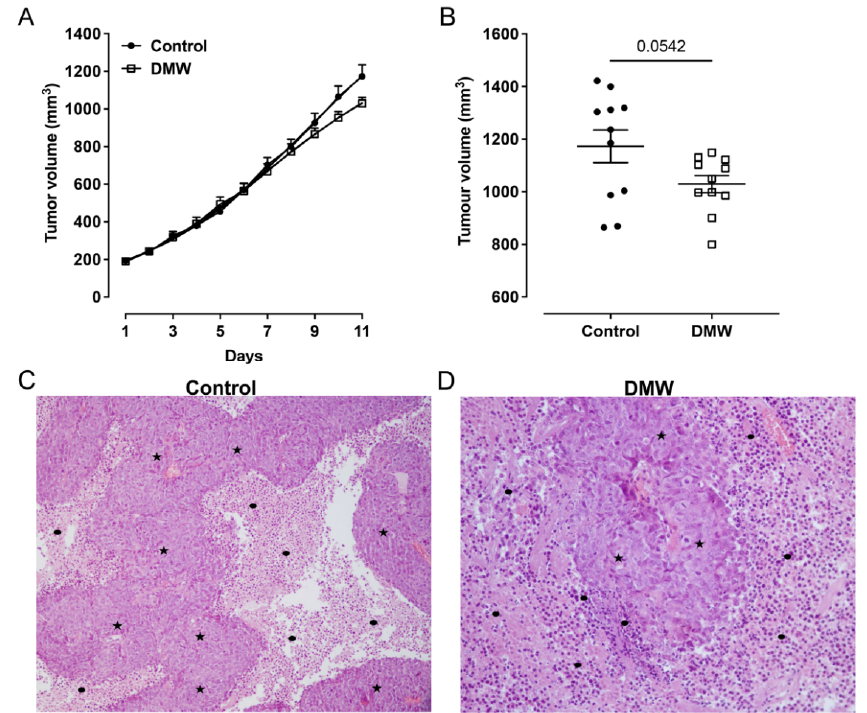
Figure 1. DMW does not significantly reduce CRC growth in vivo. ( A , B ) Effect of DMW (0.2 mL/mouse, given by oral gavage) on in vivo tumour growth, measured as tumour volume (mm 3 ), over an 11-day period. Each point is the mean ± SEM of 11 mice. ( C , D ) Histological features of control- and DMW-treated samples. Representative images of ( C ) control sample showed adenocarcinoma (stars) with central necrosis (dots) (H-E; original magnification ×10) and ( D ) DMW-treated sample showed adenocarcinoma (stars) with large areas of necrosis, which surround and invade neoplastic proliferation (dots) (H-E; original magnification ×